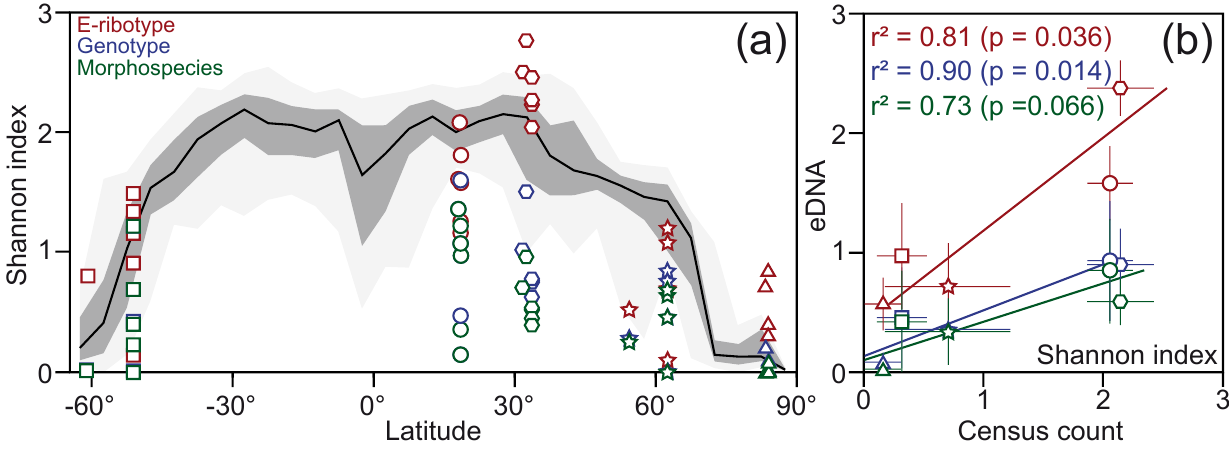
Figure 5. Macroecological pattern of spatial diversity known as the latitudinal gradient of diversity. (a) The grey areas represent the distribu- tion of the Shannon index calculated on the census count of planktonic foraminifera in core top samples from the MARGO database (Kucera et al., 2005) against latitude. The dark-grey area represents the 1st–3rd quartiles (50% confidence interval), light-grey area the 5th–95th percentile (90% confidence interval), and the black line the median. The same similarity measure has been calculated at each location for the e DNA samples based on the relative abundances with the three levels of taxonomic resolution. (b) Relationships between mean Shannon index calculated at regional levels (symbols as in Fig. 1) for census count and e DNA assemblages; vertical and horizontal lines indicate the standard deviation. Coefficient of correlation and p values are provided for the three taxonomic levels but are only indicative because the number of data points is too low to draw a definitive